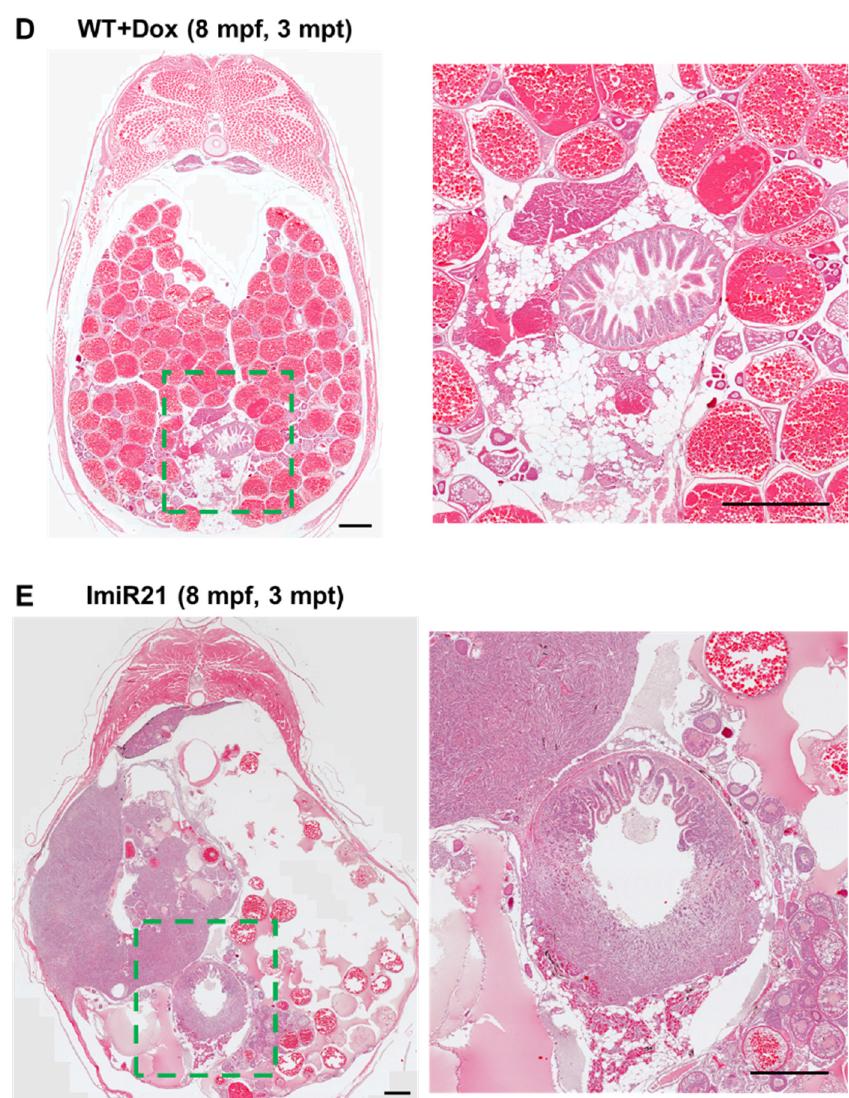
Figure 6. Chronic effects of intestinal miR-21 expression on colitis-associated cancer (CAC). ( A ) Representative images of gross intestinal phenotypes at 7 months post-fertilization (mpf)/2 months post-treatment (mpt) of WT + Dox and ImiR-21 + Dox. Scale bar: 2 mm. ( B ) H&E-stained intestinal sections of 7 mpf/2 mpt WT + Dox and ImiR-21 + Dox. ( α and α ’) Intestinal bulb. ( β and β ’) Mid-intestine. ( γ and γ ’) Edge of mid-intestine and posterior intestine. Scale bar: 250 µ m. ( C ) RT-qPCR analysis of the mRNA expression of the CAC-associated genes in the intestine of 7 mpf/2 mpt WT + Dox and ImiR-21 + Dox. Gene expression levels were normalized to gapdh levels in WT + Dox. Statistically significant differences from WT + Dox are denoted by * ( p < 0.05), ** ( p < 0.01), and *** ( p < 0.001). Representative images of H&E-stained sections of ( D ) WT + Dox and ( E ) ImiR-21 + Dox at 8 mpf/3 mpt. Scale bar: 2